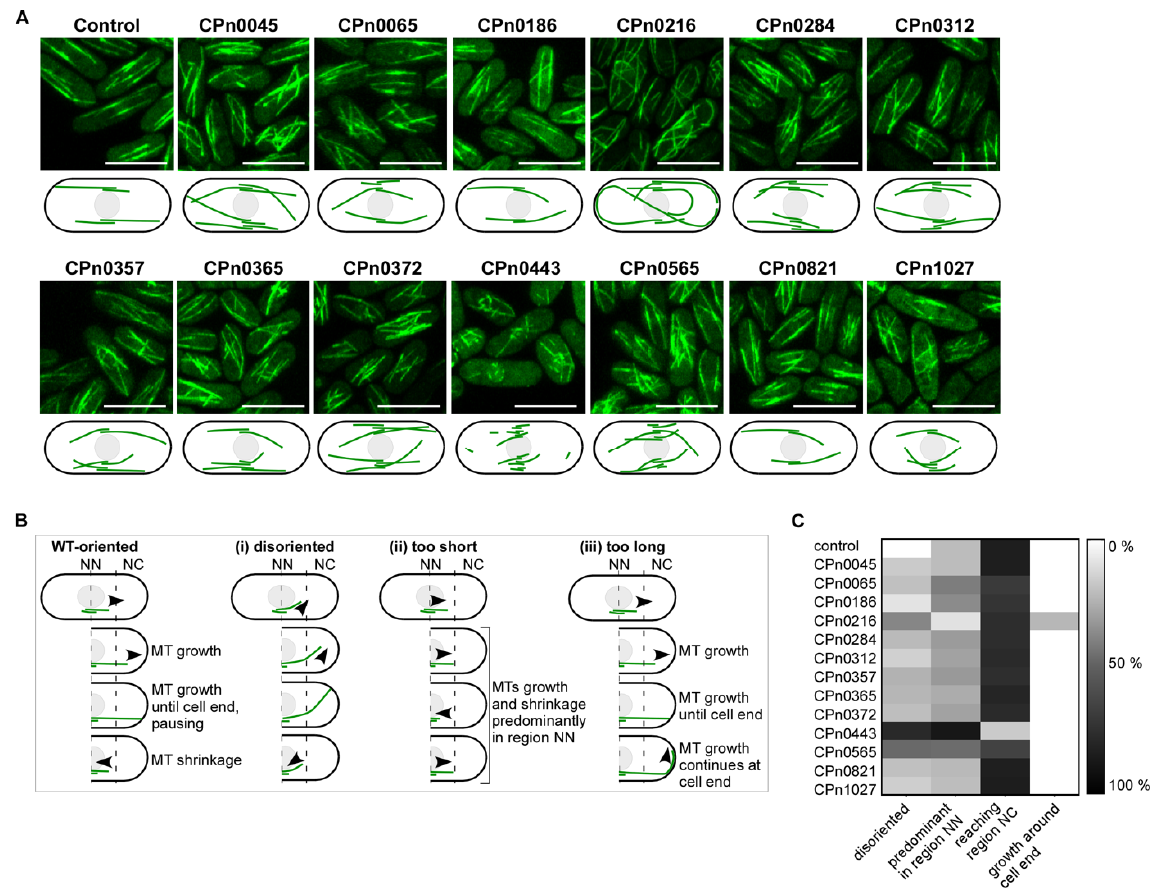
Figure 4. Cpn proteins cause massive alterations in the S. pombe interphase MT cytoskeleton. S. pombe cells that expressed gfp- α -tubulin ( nmt81::GFP-atb2 + ) were transformed with a control plasmid or plasmids carrying one of the 13 Cpn genes highly expressed from the nmt1 + promoter. ( A ) Pho- tomicrographs (MTs in green) and the corresponding schematic representations. Scale bars: 10 µ m. ( B ) Schematic illustration of WT interphase MT dynamics and the alterations observed for Cpn gene expressing cells. (i) Disoriented MTs, (ii) aberrantly short MTs or (iii) aberrantly long MTs. Black arrowheads show the directions moved for growing/depolymerizing MT. Cells were divided into 3 parts: the middle region was defined as being close to the nucleus (NN) and the other two regions as NC (regions close to either cell end). ( C ) Heatmap of the aberrant interphase MT phenotypes caused by Cpn proteins as described in ( B ). A total of 100 MTs/transformant strains were counted for disoriented MTs, MTs predominant in region NN only, MTs reaching the cell end (region NC) and MTs that continued to grow when the cell end had been reached (growth around cell